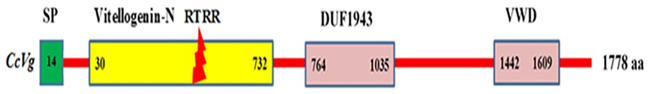
Schematic representation of the Cadra cautella full length vitellogenin (CcVg) protein.The CcVg protein is 1,778 amino acids long. The green rectangle at the beginning of the Vg-bar represents the signal peptide (SP). The numbers in the rectangle frames represent the amino acid position of three conserved domains.